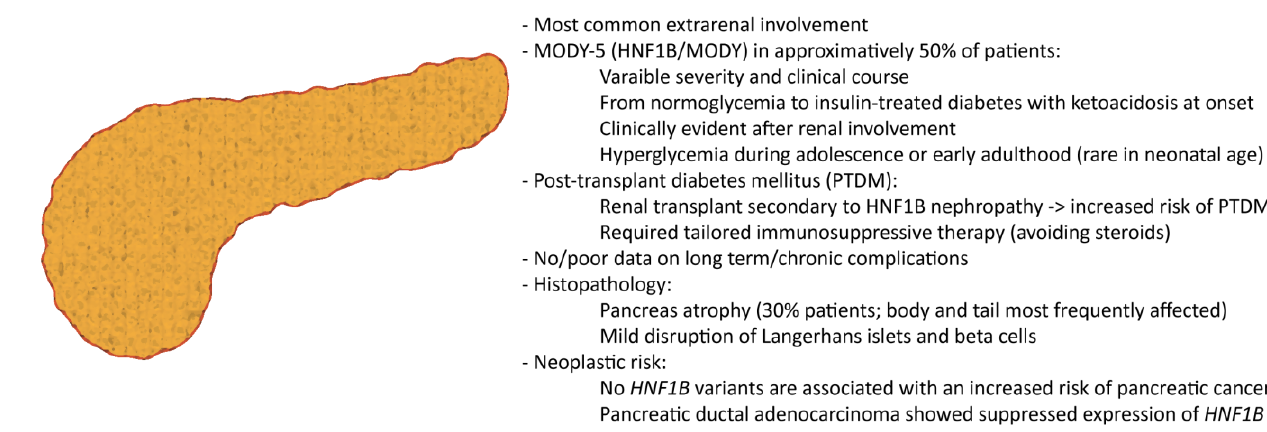
Figure 3. The HNF1B deficiency and the